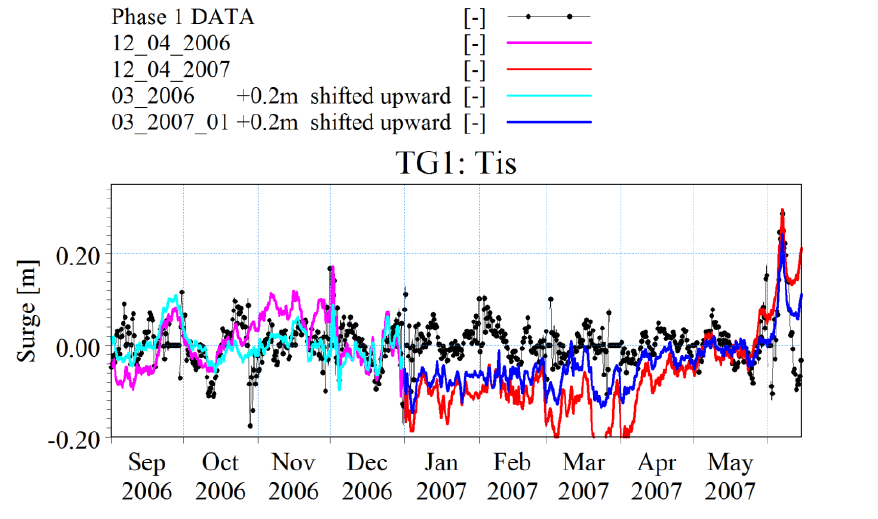
Figure 11. Comparisons on computed sea level change and filtered surge from Tis tide